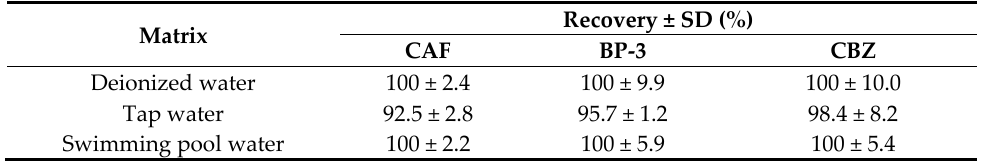
Table 6. Recoveries obtained in the most optimal Solid Phase Extraction methodology (Methanol + Acetonitrile and ENVI-18 Tube) for different matrices.